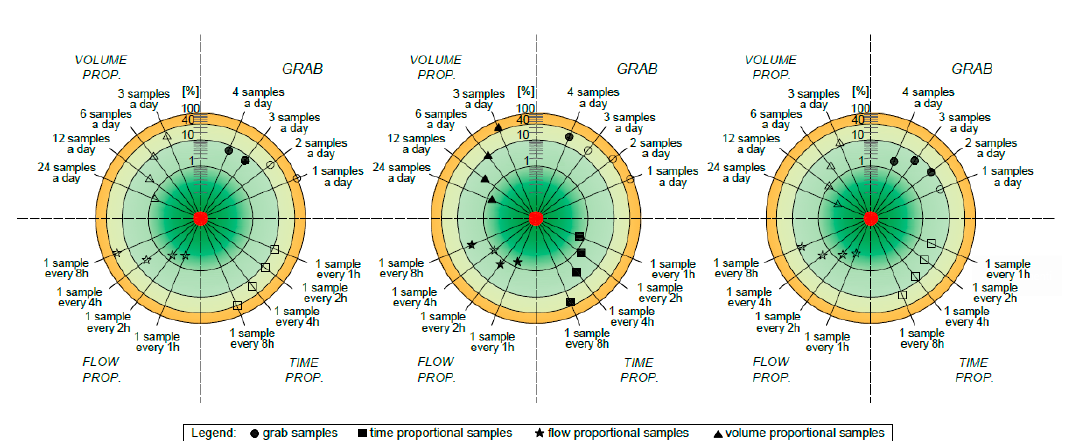
Figure 6. Percentage deviations between the ideal concentration of each substance (red dot) and the measured average concentrations found following the different sampling modes, defined in Table 1. Circumferences in the three graphs refer to the different values of percentage deviation on a log scale. Full symbols correspond to an overestimation and empty symbols to an underestimation.